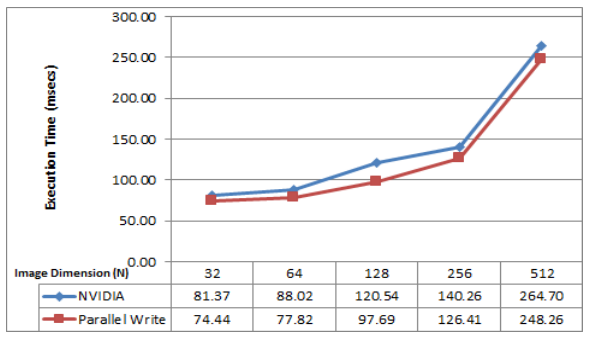
Figure 9: Exec. Time of recursive gaussian using NVIDIA Transpose and Proposed Parallel Write al- gorithms